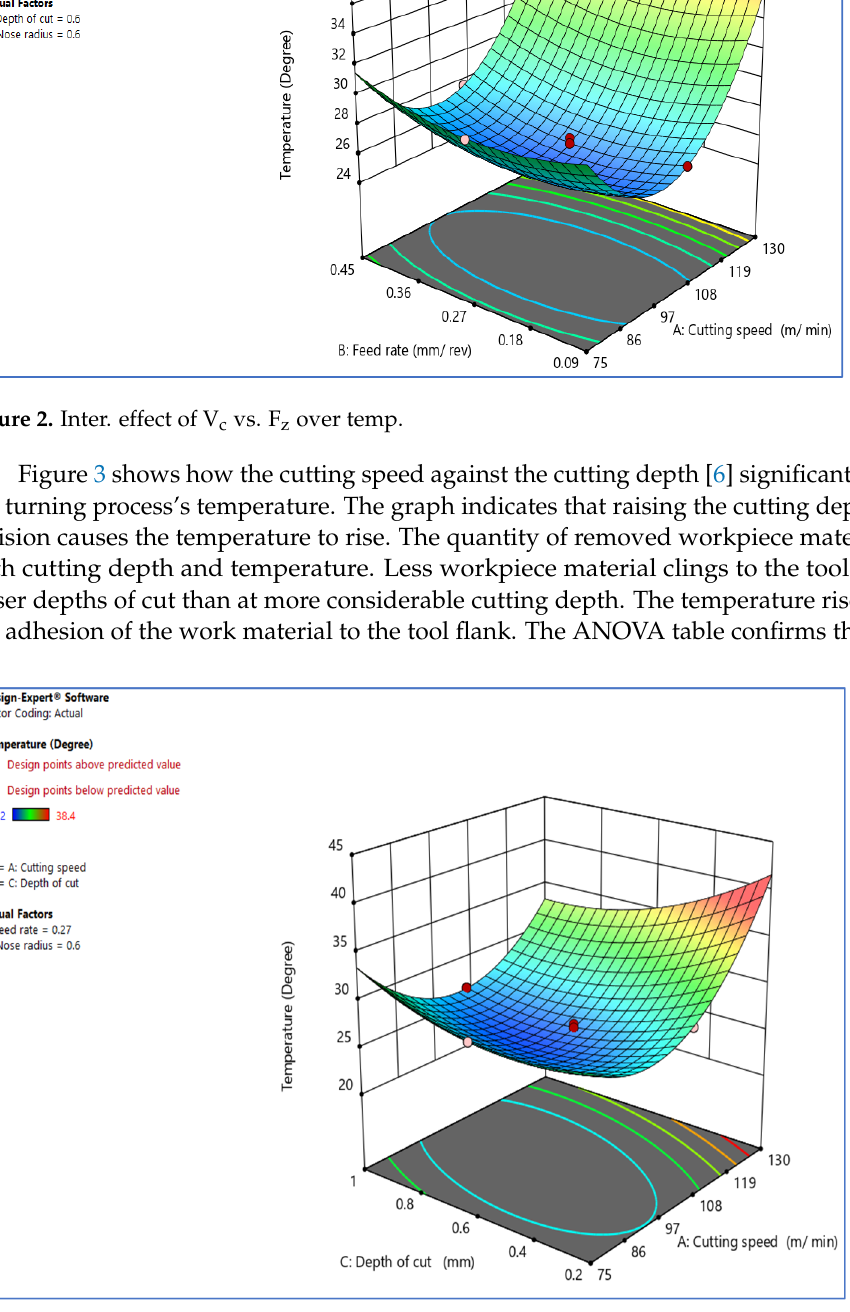
Figure 3. Inter. effect of V c vs. D c over temp.